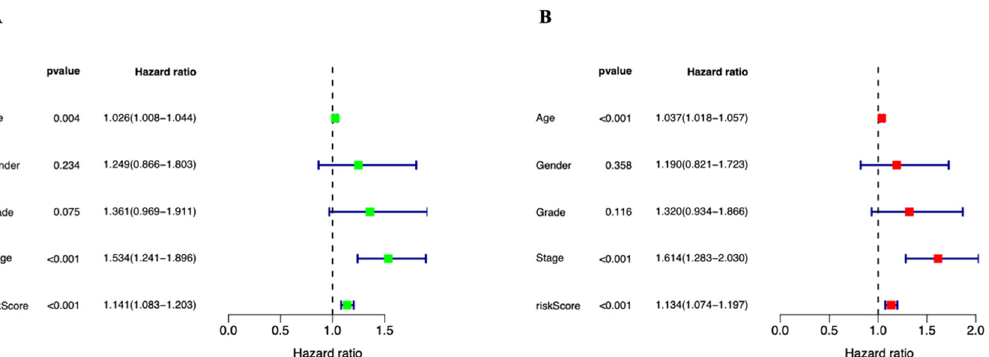
Figure 5. Independence of the cuproptosis-related lncRNAs prognostic marker in predicting overall survival of STAD patients. ( A ) Univariate Cox analysis. Age, stage, and risk score were statistically significant in predicting the overall survival of STAD patients. ( B ) Multivariate Cox analysis. Age, stage, and risk score were statistically significant in predicting the overall survival of STAD patients.